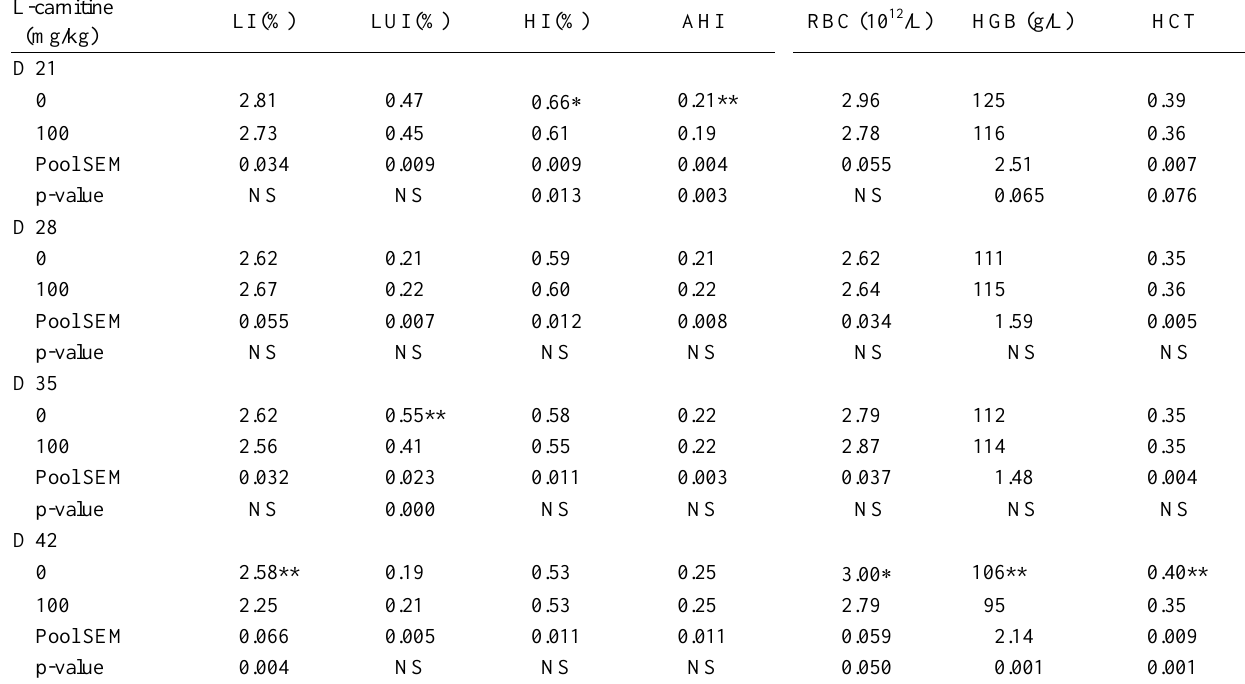
Table 3. Effects of dietary L-carnitine supplementation on broiler organ index and blood parameters a L-carnitine